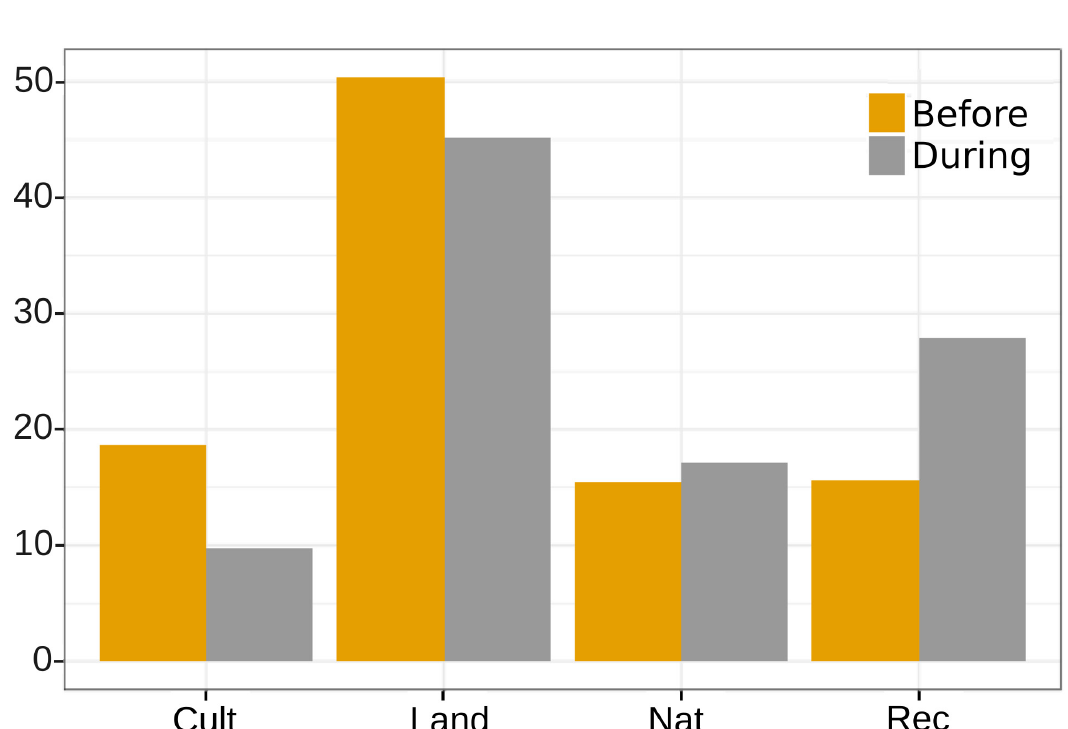
Figure 2. Percentage of Cultural Ecosystem Services represented along the Brazilian coast, before and during the oil spill.